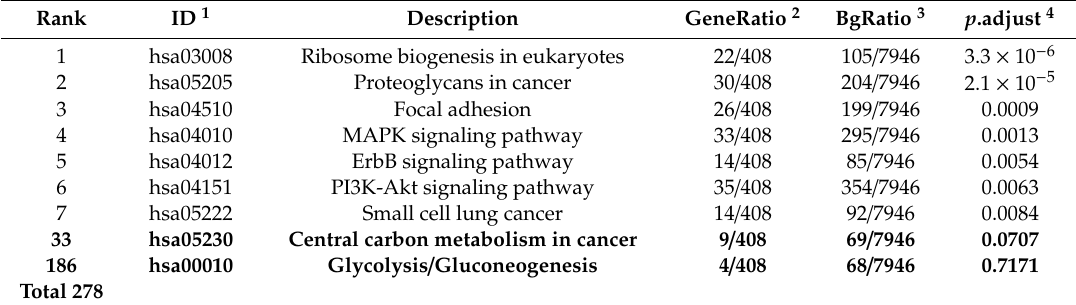
Table 1. Upregulated signaling pathways upon HGF stimulation in Detroit 562. Ranking based on adjusted p -value ( p .adjust). Results of the first seven pathways on the list and of two pathways of interest are shown. Only genes that are part of at least one of the pathways listed in KEGG and that show a di ff erence in expression of ≥ 0.4 (log 2 fold change) and p adj < 0.1 are included.